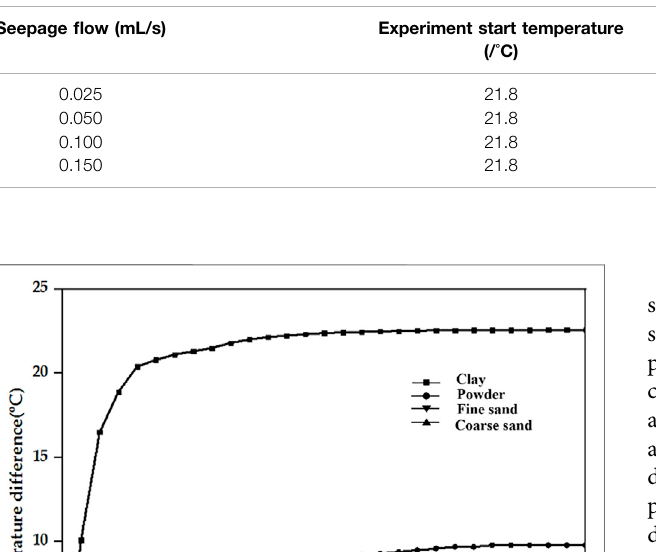
TABLE 2 | Measured temperature characteristics of seepage sensor under different seepage fl ows.